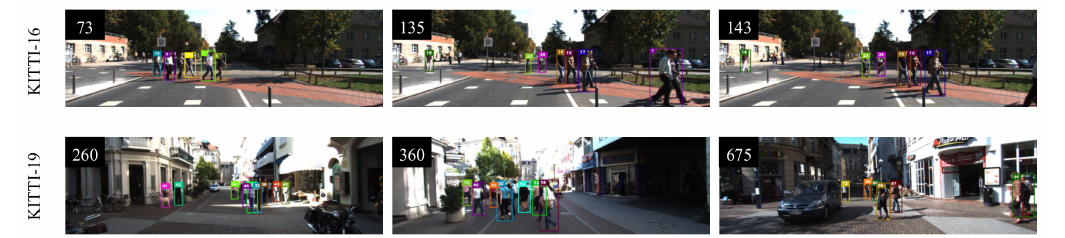
Figure 8. The tracking results of our algorithm on the KITTI dataset.